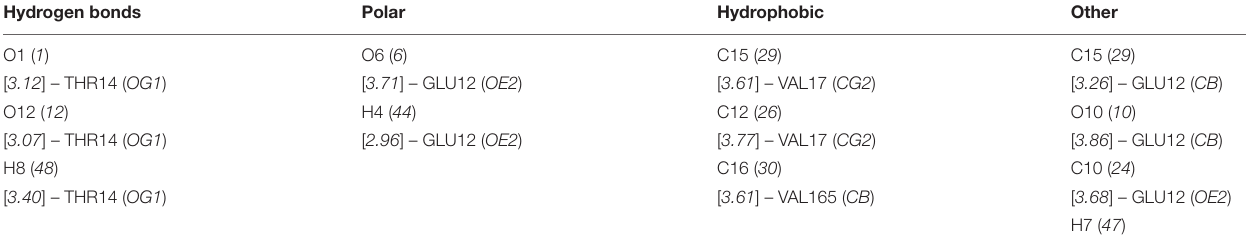
TABLE 2 | Interaction table of schaftoside and NlCDK1 protein. Hydrogen bonds Polar Hydrophobic